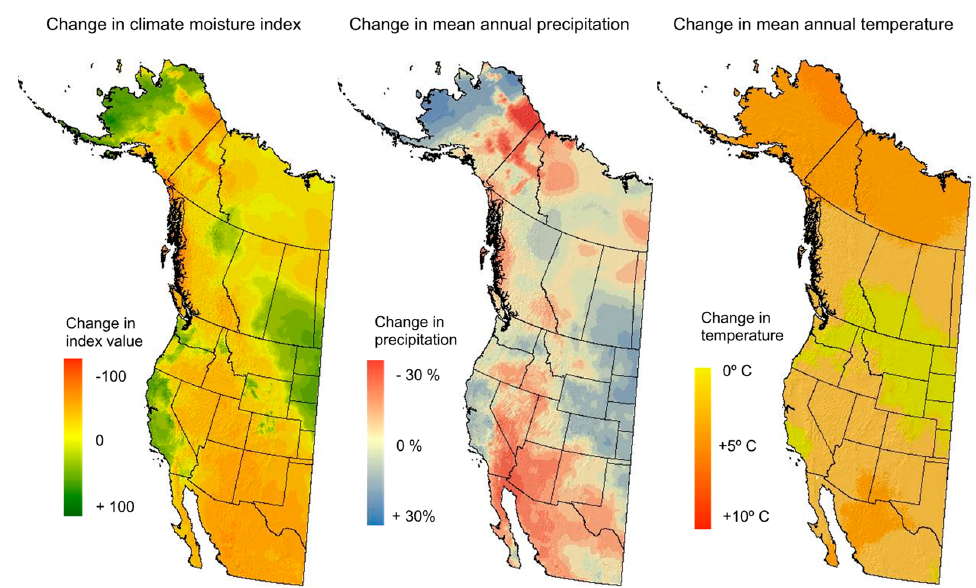
Figure A1. Change in climate moisture index values in the context of underlying changes in precipitation and temperature across western North America. The maps are based on the CRU-TS 4.05 database [31] and were processed through the ClimateNA software package [29]. For all three variables, the maps represent the difference between the 1961–1990 historic climate normal period